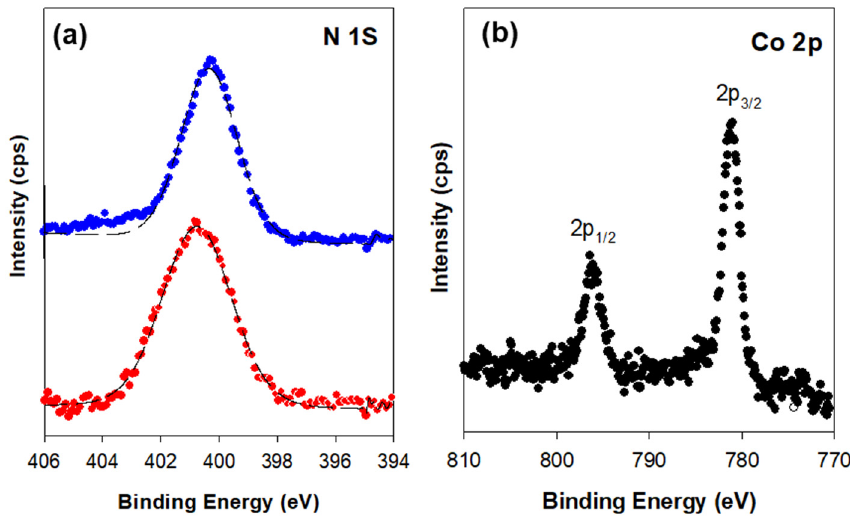
Figure 6. ( a ) High-resolution XPS spectra of N1s for Im-EtPMO (red line) and Im-EtPMO-Co (blue line). ( b ) High-resolution Co2p XPS spectrum for Im-EtPMO-Co.